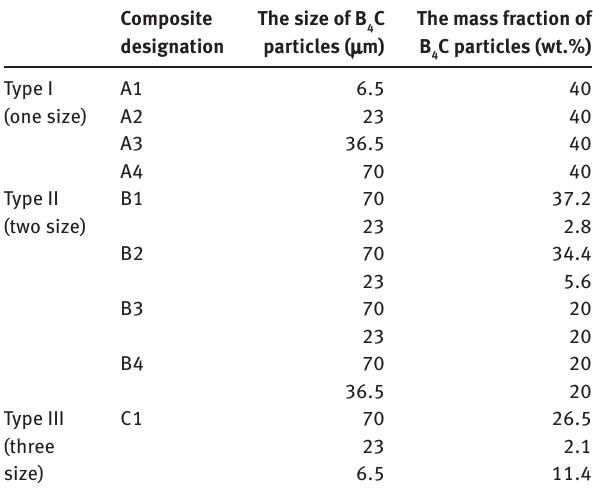
were cut into small sizes (20 mm × 20 mm × 15 mm) by line